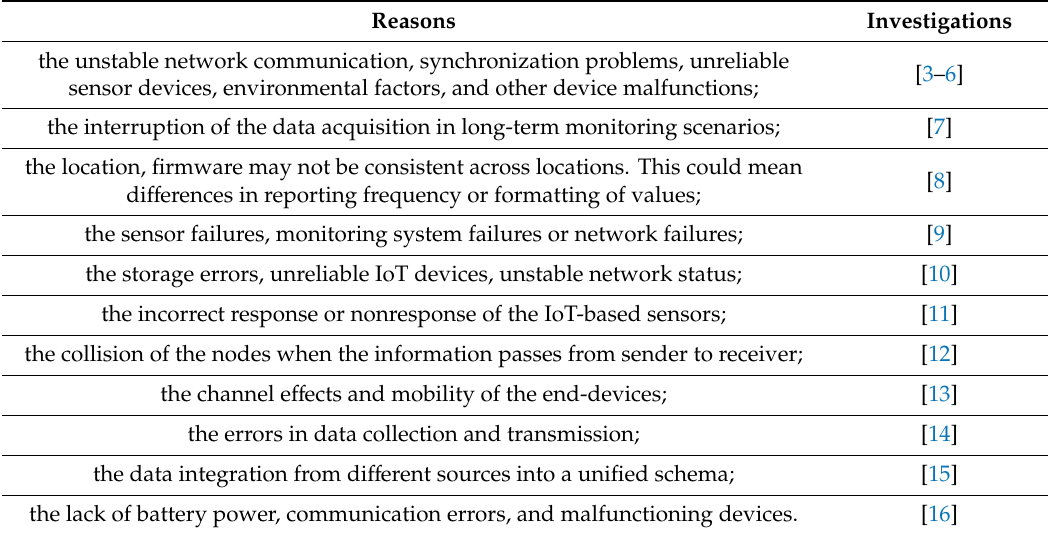
Table 1. Reasons for the omission in data collected by IoT